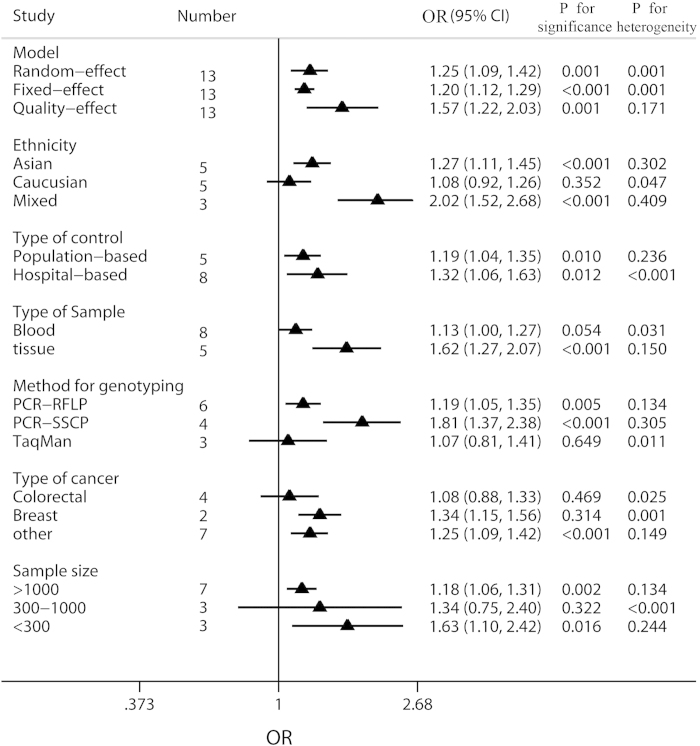
Meta-analysis of the association between Int7G24A polymorphism and cancer
risk applying allele model (A vs. G).The triangles and horizontal lines correspond to the subgroup-specific ORs
and 95% CIs. The vertical solid line shows the OR of 1. Especially,
“Other” indicates other kind of cancer in addition
to breast cancer and colorectal cancer, including 2 ALL studies (T-lineage
and B-lineage), 1 cervix cancer study, 1 NSCLC study, 1 osteosarcoma study,
1 RCC study, 1 TCC study, 1 ESCC study, 1 colon adenoma study, and 1 GCA
study; “Mixed” means mixed population with Caucasian
and African-American.